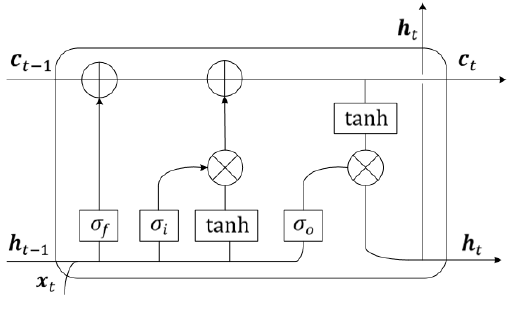
Figure 6. LSTM cell structure.